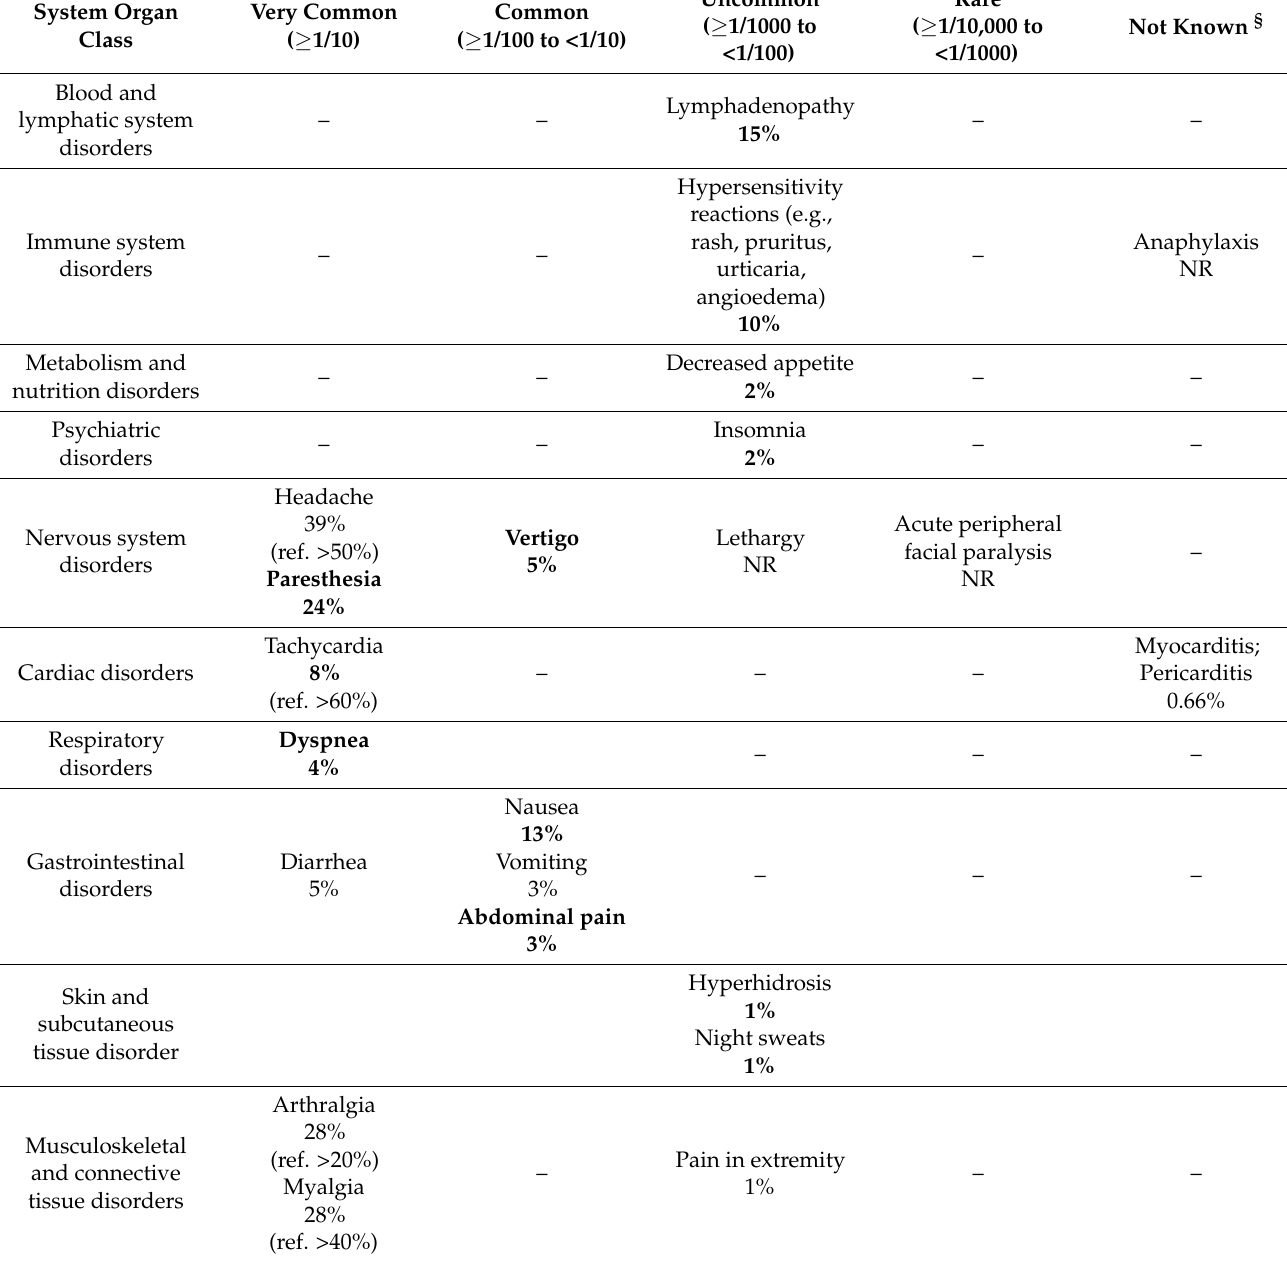
Table 2. Detailed FPG safety results compared to the SPC of